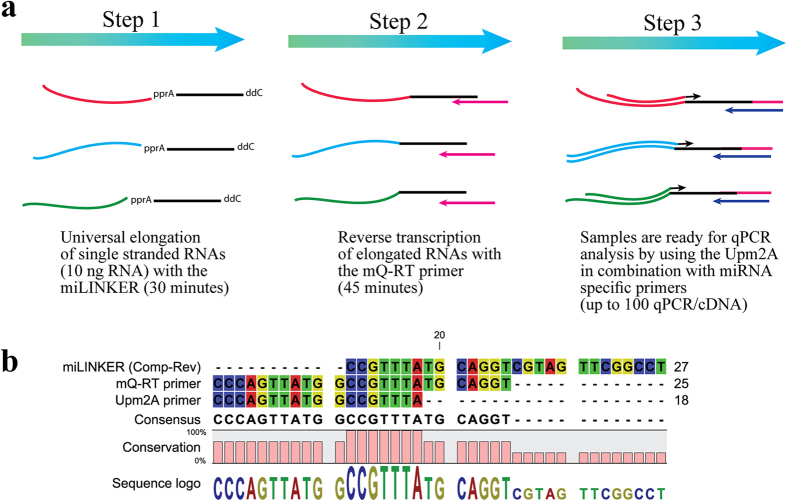
Workflow of cDNA synthesis following the miQPCR approach.a) During the first step the 3′-end of ssRNA is enzymatically ligated to the
5′ end of miLINKER by truncated T4 RNA ligase (time ~30 min). In the second
step, a reverse transcriptase is used to reverse transcribe elongate miRNAs into cDNA with a
universal reverse-transcription primer (mQ-RT, time ~45 min). In the third and final
step, cDNA is diluted, the miRNA of interest is amplified by qPCR using a reverse universal primer
(Upm2A) and a forward miRNA-specific primer while the amplicon is detected by using SYBR Green I.
b) Multiple alignment among the complement reverse of the linker adaptor (miLINKER) and the
sequences of the reverse transcription primer (mQ-RT) and of the universal qPCR primer (Upm2A). All
the sequences are indicated in the 5′ → 3′ orientation. For miLINKER, mQ-RT
and Upm2A sequences see Supplementary Table 1a and
1b.